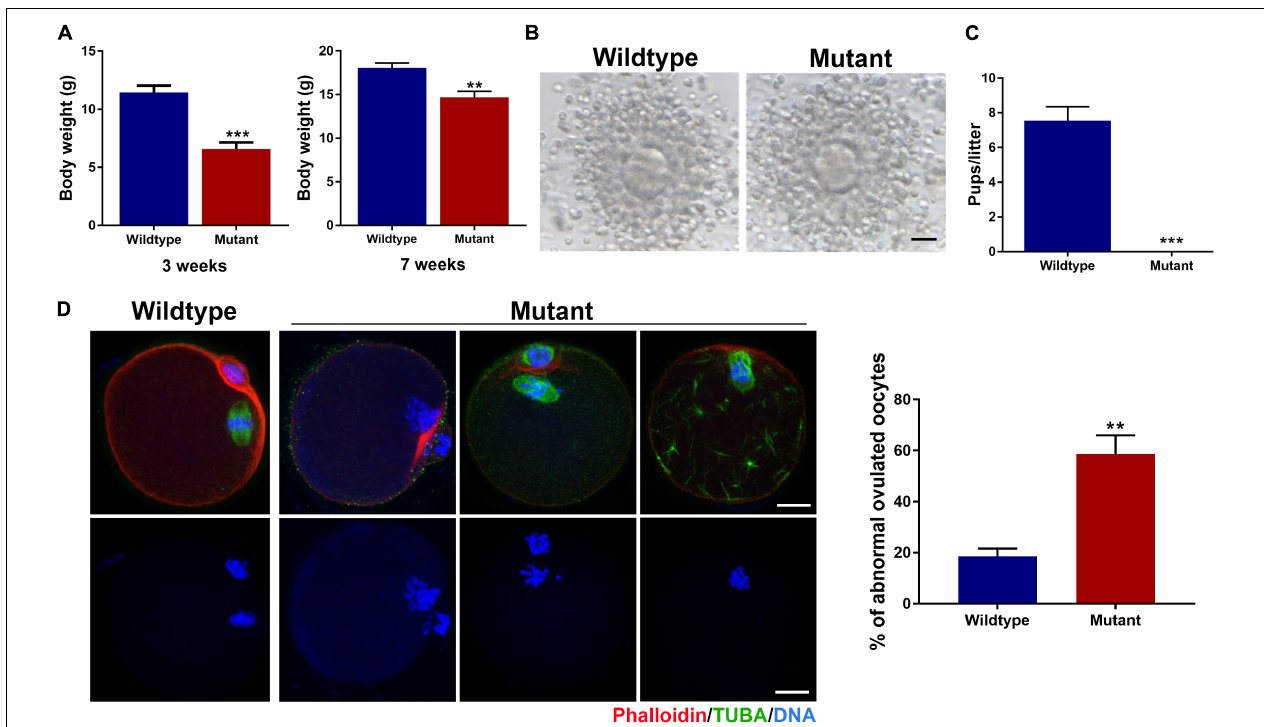
FIGURE 1 | Growth and fertility defects in female mice carrying the ENU-induced nonsense mutation of Eml1 . (A) Comparison of body weight between wildtype and Eml1 -mutant (Mutant) female mice at the age of 3 and 7 weeks. (B) Microphotographs showing the ovulated cumulus-oocyte complexes by Wildtype and Mutant females. Scale bars indicate 10 µ m. (C) Fecundity (pups/litter) of WT ( n = 3) and Mutant ( n = 3) female mice during the 2 month fertility test period. *** P < 0.005, compared with the Wildtype. (D) Assessment of spindle morphology and chromosome alignment in the Wildtype and Mutant ovulated oocytes. The left panel shows the representative micrographs of the IF stained oocytes. Spindles are stained in green, chromosomes and F-actins are stained in blue and red, respectively. Scale bars indicate 20 µ m. The right bar graph shows the percentage of the oocytes with abnormal spindles and/or misaligned chromosomes. ** P < 0.05, compared with the